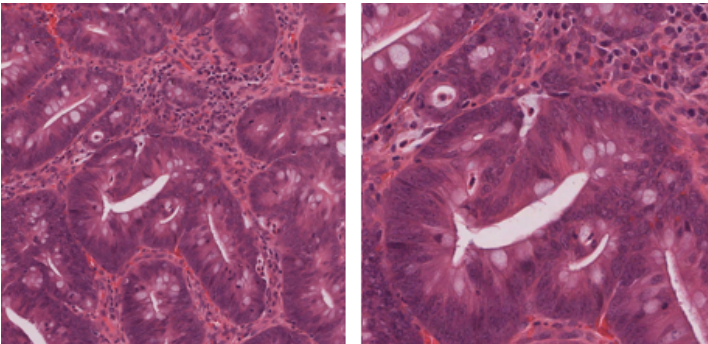
Figure 2. Colorectal tissue patches of a tubular adenoma at two different magnifications: 20 × ( left ) and 40 × ( right ).